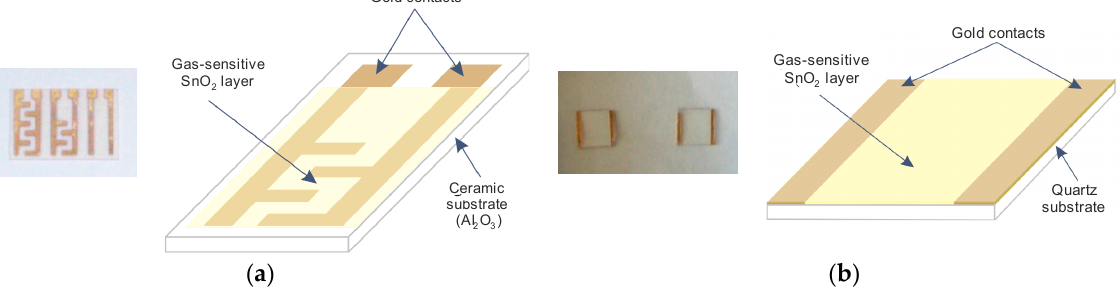
Figure 1. Photo and schematic of a model resistive-type sensor structure with a SnO 2 sensor film fabricated using ( a ) RGTO or ( b ) DC reactive magnetron sputtering.